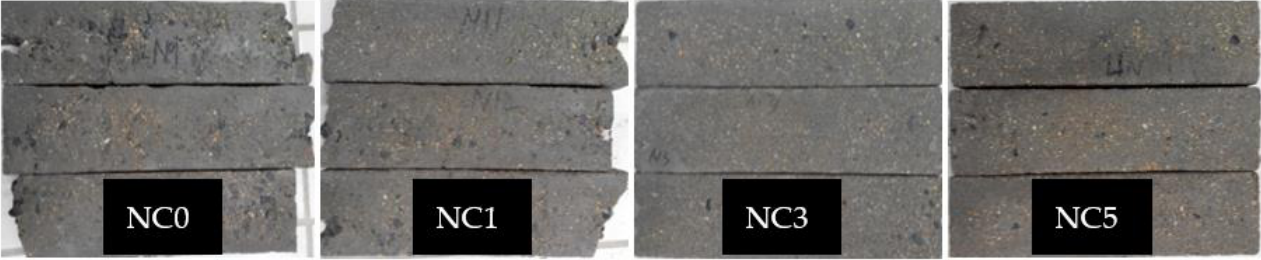
Figure 4. Surfaces of concrete after 125 freeze – thaw cycles. After 50, 75, and 100 freeze-thaw cycles, the surface cracks of NMK concrete are shown in Figure 5, and it shows that no obvious cracks appeared on the surface of NMK concrete before 50 freeze-thaw cycles. The concrete is in the induction period of freeze-thaw damage, and the micro-cracks in the matrix begin to appear but do not extend to the concrete surface. After 75 freeze-thaw cycles, macro cracks started to appear on the surface of NC0 and NC1 specimens and entered the accelerated period of freeze-thaw damage. The cracks gradually expanded and interconnected. There is no macroscopic crack on the surface of NC3 and NC5 samples, which is still in the induction period of freeze-thaw damage. When the number of freeze-thaw cycles reached 100, many visible cracks with wide width appeared on the surface of NC0 and NC1 specimens, accompanied by severe concrete spalling. At this time, the concrete has been in a stable growth period of freeze-thaw damage and is in a failure state. There are only a small amount of tiny cracks on the surface of NC3 and NC5 specimens, which have just entered the accelerated period of freeze-thaw damage to concrete. From the above analysis, it can be concluded that the appropriate amount of NMK can effectively hinder the occurrence, expansion, and connection of micro-cracks in the concrete matrix during the freeze-thaw cycle and delay the damage to the concrete structure. Visual inspections of the surface of different specimens are in good agreement with the results of Kalhori H, et al. [7].